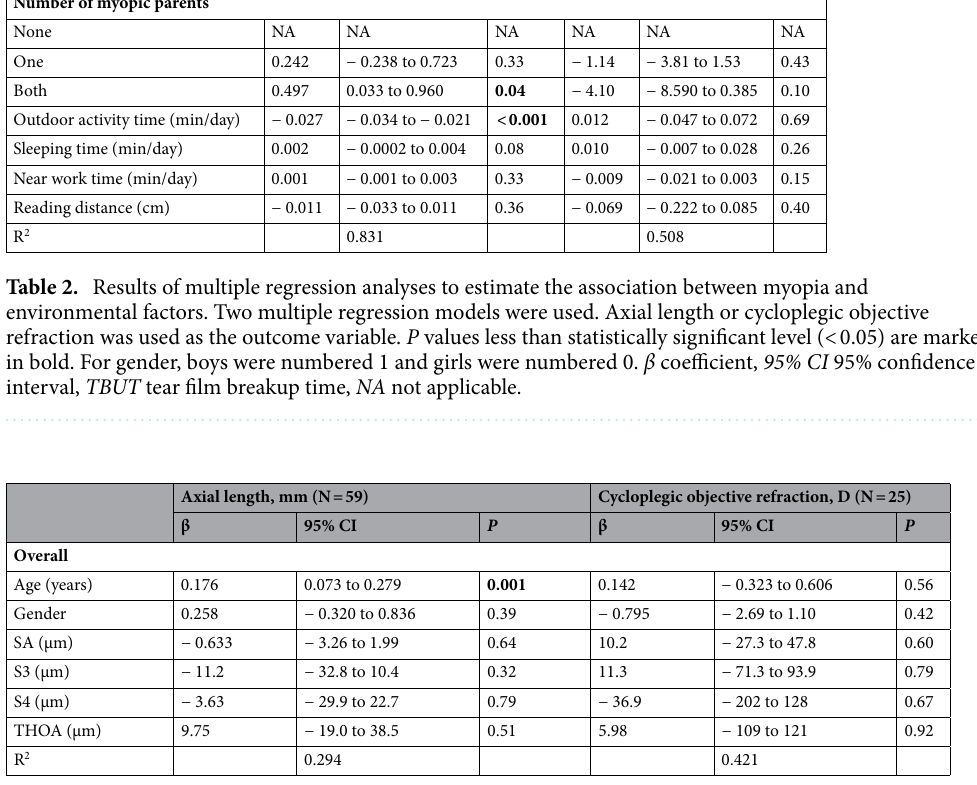
Table 3. Results of multiple regression analyses to estimate the association between myopia and corneal higher order aberrations (evaluated with natural pupillary diameters, average value φ = 6.1 mm). D diopters, SA spherical aberration, S3 3rd-order aberrations, S4 4th-order aberrations, THOA sum of the 3rd- to 6th-order aberrations, 95% CI 95% confidence interval, β coefficient. Two multiple regression models were used. Axial length or cycloplegic objective refraction was used as the outcome variable. P < 0.05 are highlighted. For gender, boys were numbered 1 and girls were numbered